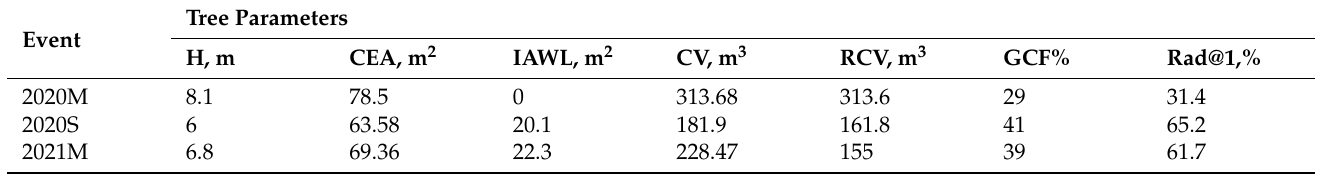
Table 5. Average height, external and internal canopy areas, external and real canopy volume, ground